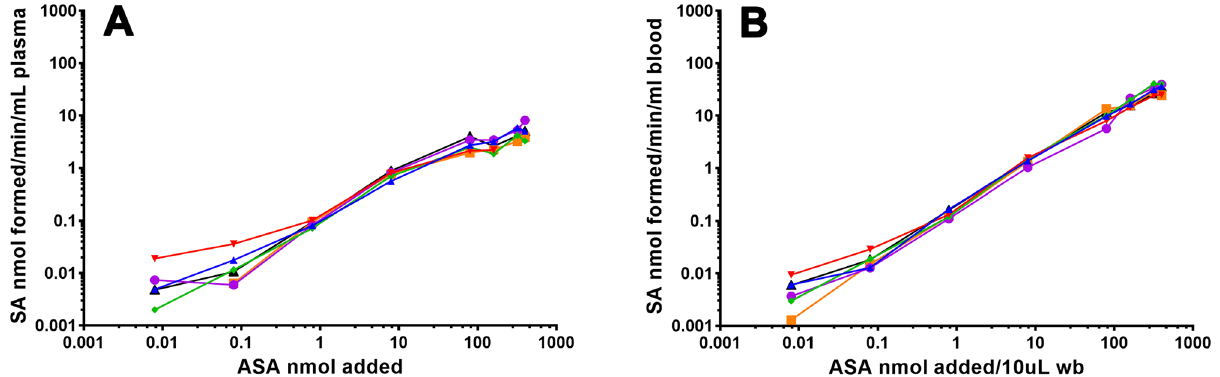
Figure 3. Esterase activity after 2 h incubation as a function of substrate concentration in plasma ( A ) and whole blood ( B